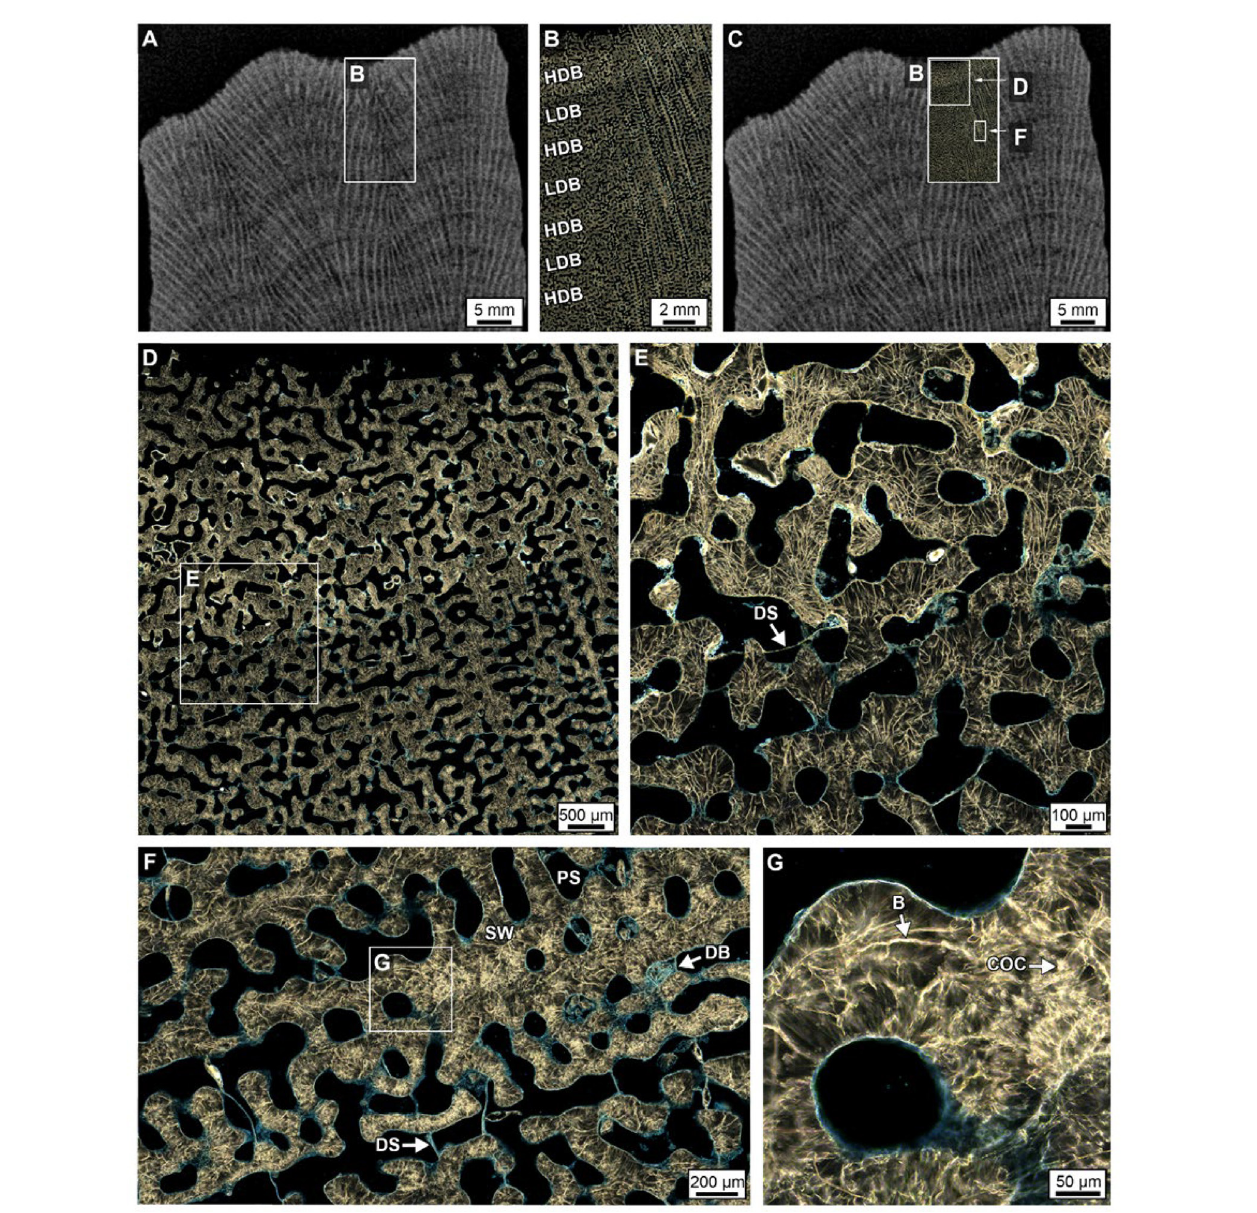
FIGURE 5 | Crystalline structure of high- and low-density bands (HDBs and LDBs) within the uppermost 2 cm of Core 3. (A–C) Overlay of a ring aperture contrast (RAC) image on an XRD showing the precise location of coral skeleton density banding (CSDB) on the thin section. (D,E) RAC images of an HDB-LDB contact associated with the first dissepiments (DS) below the uppermost growing surface of the corallum. (F,G) RAC images (location of F shown in C and rotated 90 ◦ ) of an HDB-LDB contact showing bright centers of calcification (COCs) and borings